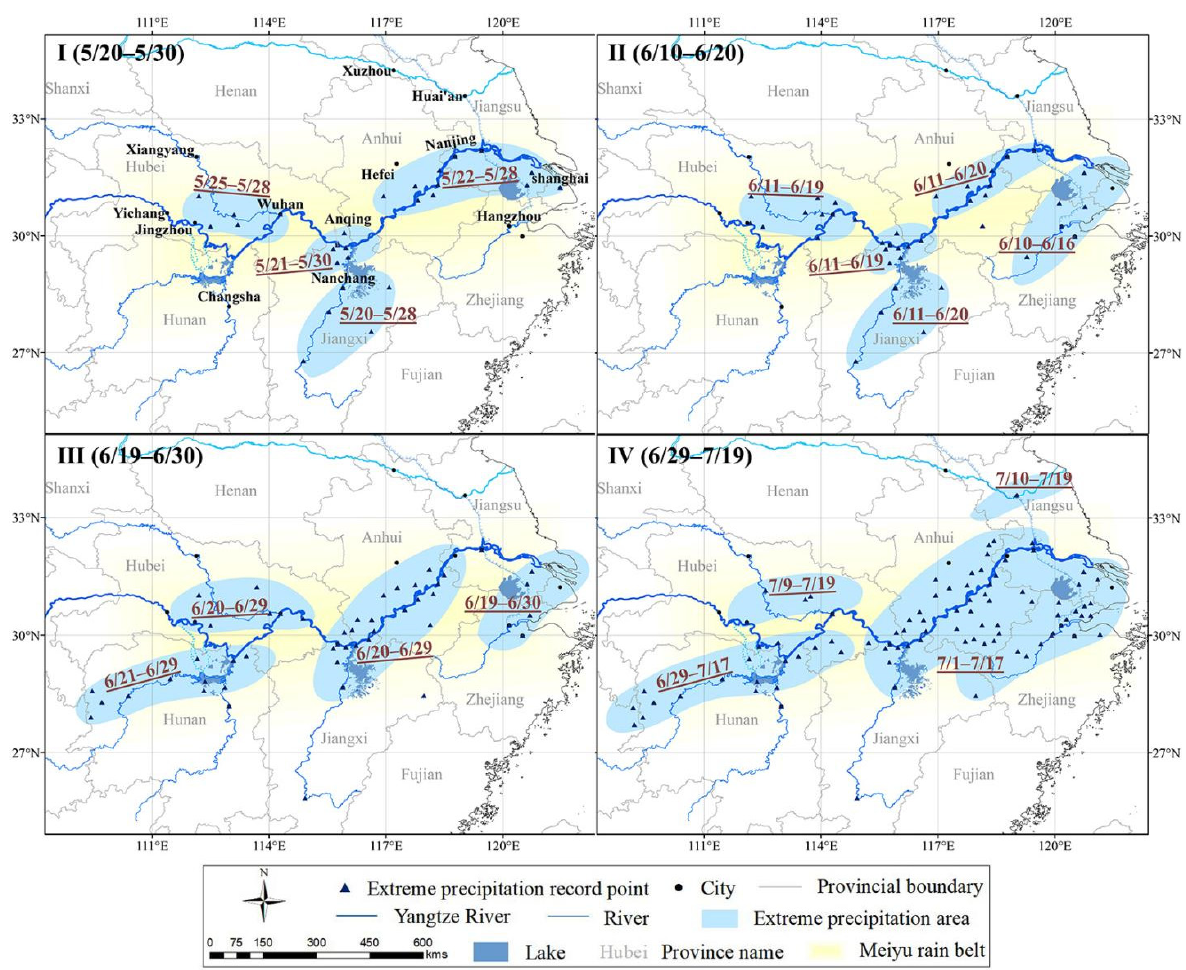
Figure 2. Distribution maps of four precipitation events in summer of 1849. ( I ): spatial distribution of the first precipitation event, ( II ): spatial distribution of the second precipitation event, ( III ): spatial distribution of the third precipitation event, ( IV ): spatial distribution of the fourth precipitation event. The date, such as “5/25–5/28”, is the duration of heavy precipitation in the